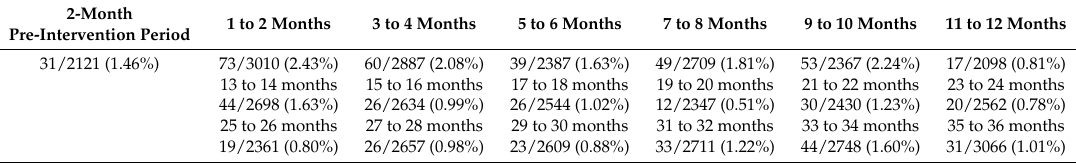
Table 3. Incidence of hypoglycemia in the 31 participants who received insulin and maintained blood glucose self-monitoring records while on a moderately low-carbohydrate diet for 36 months.